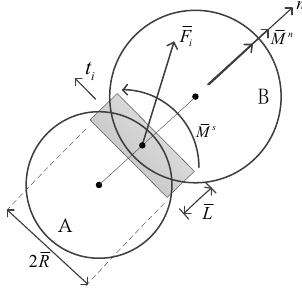
Figure 2. Particle contact model.